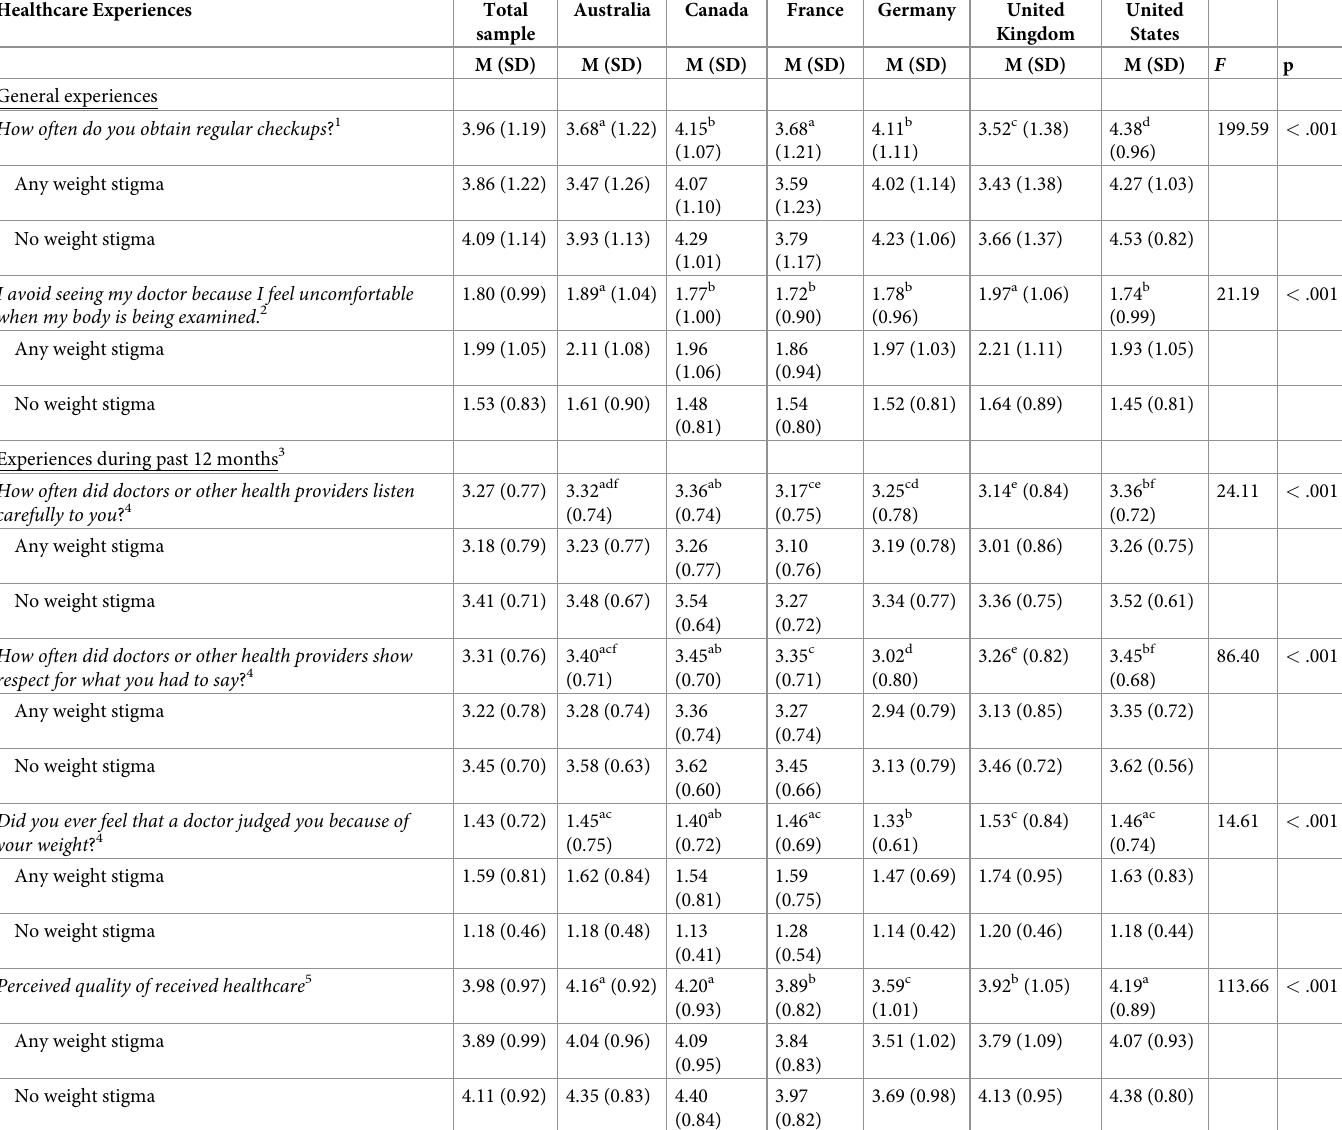
Table 2. Descriptive information about healthcare experiences, stratified by country and experienced weight